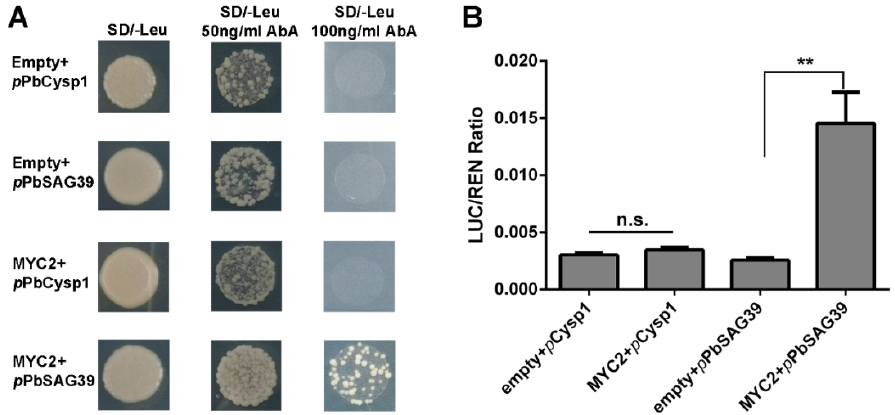
Figure 6. PbMYC2 promotion of PbSAG39 expression by direct binding to the PbSAG39 promoter. ( A ) Yeast one-hybrid assay verified the interaction of PbMYC2 with PbCysp1 and PbSAG39 . ( B ) Vali- dation of the activation effect of PbMYC2 on the PbSAG39 promoter based on a dual-luciferase assay. Relative promoter activity is represented by the ratio of the activity of the structural gene luciferase (LUC) to that of 35S Renilla (REN). An empty vector was used as a reference. Asterisks indicate significantly elevated LUC activity compared with that in the negative control (** p < 0.01, Student’s t -test). n.s., no significance.